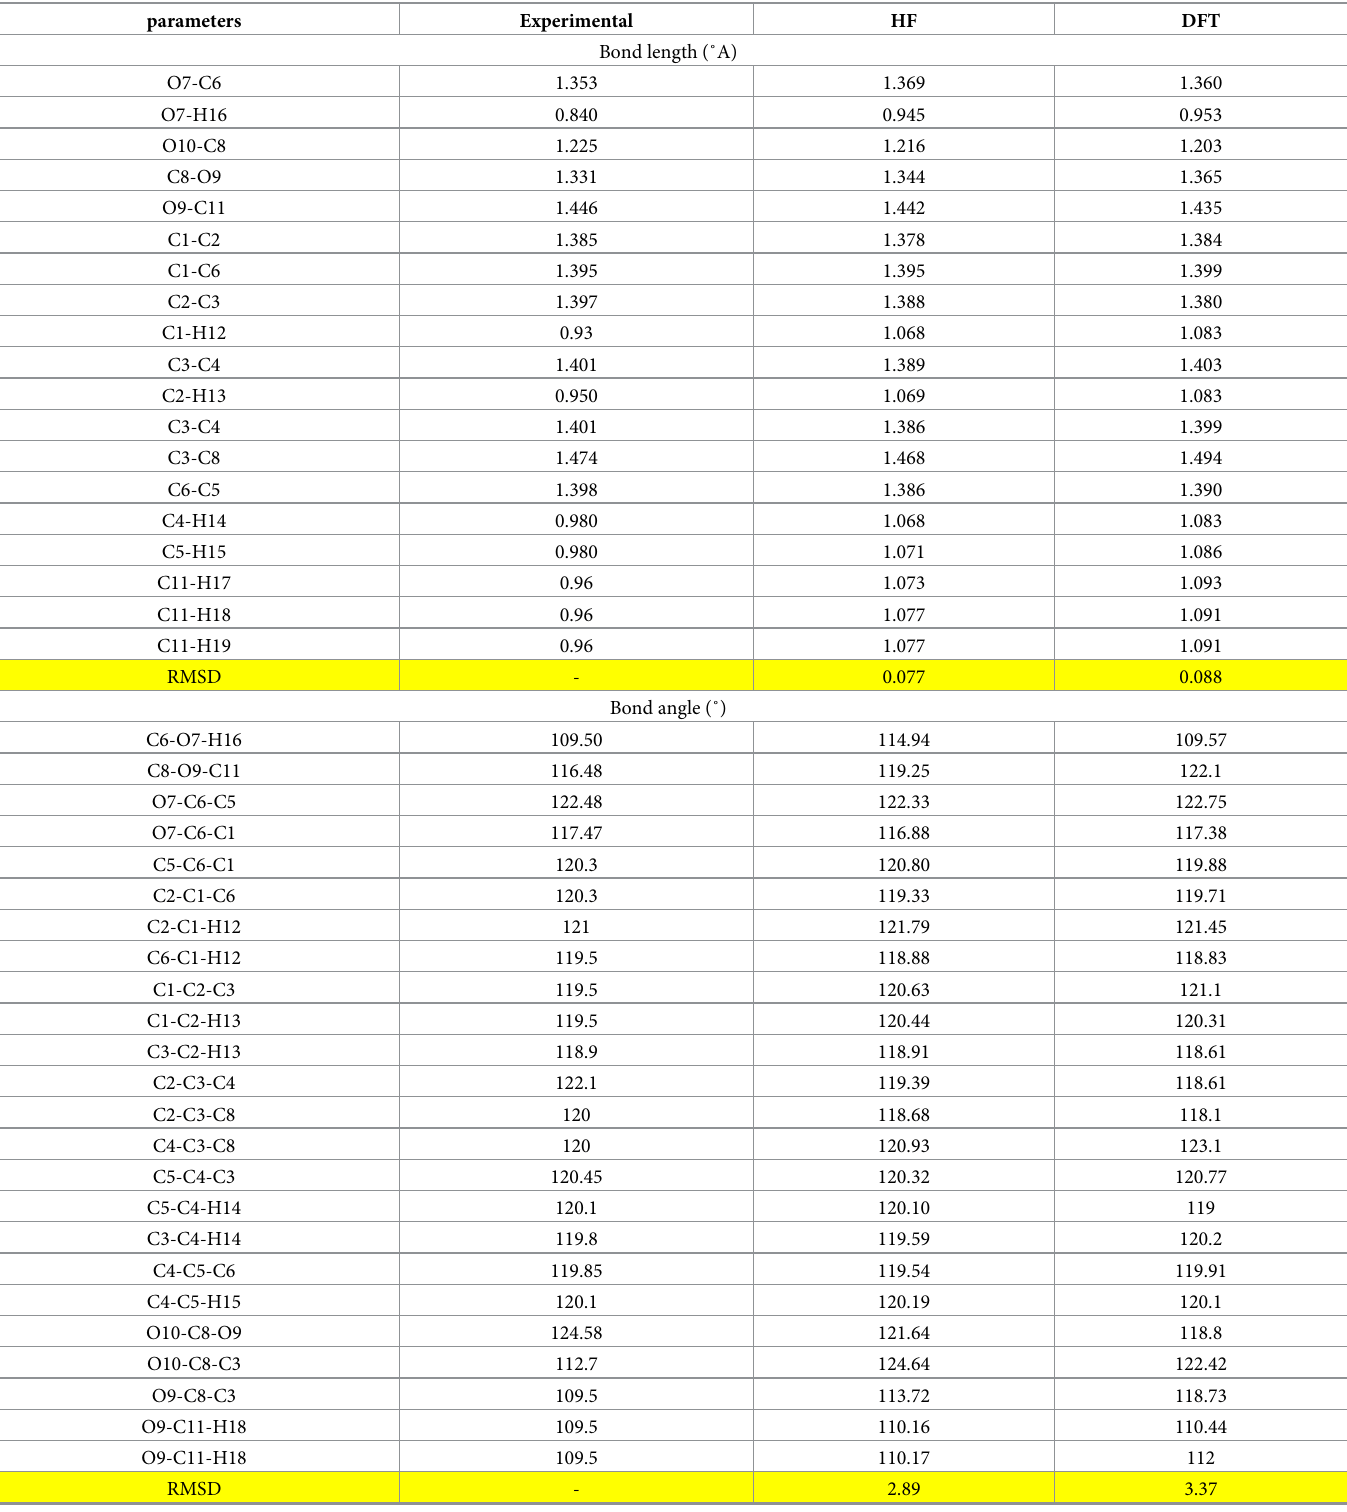
Table 2. The optimized molecular geometrical parameters of methyl